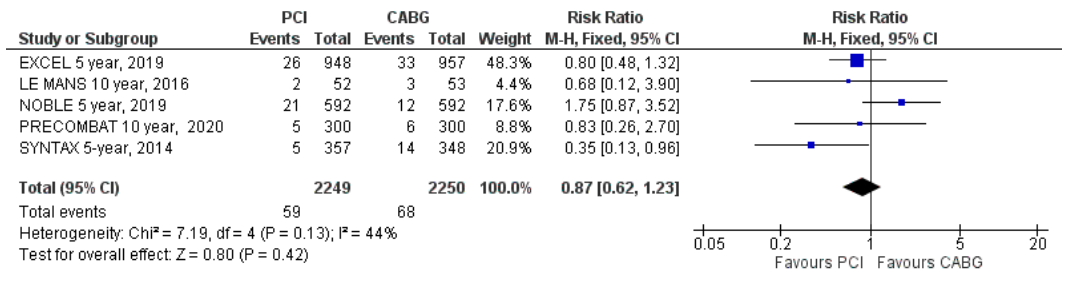
Figure 4. Risk of cardiovascular mortality at latest follow-up: PCI vs. CABG.